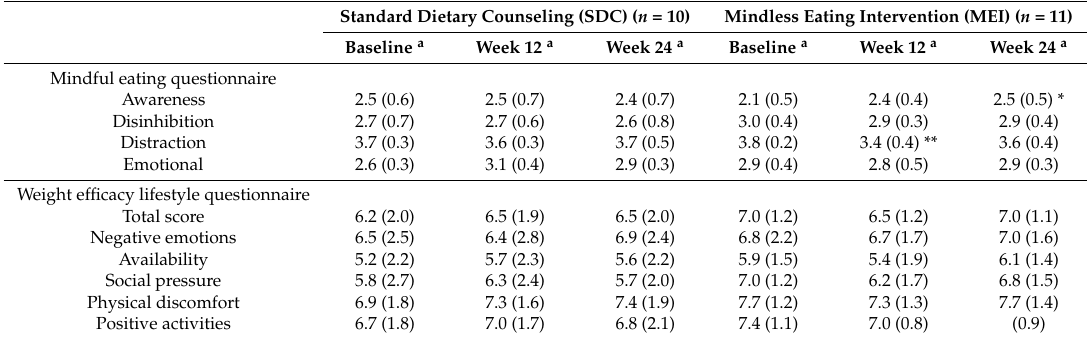
Table 3. Changes in mindful eating questionnaire (MEQ) and weight-efficiency lifestyle questionnaire (WEL)